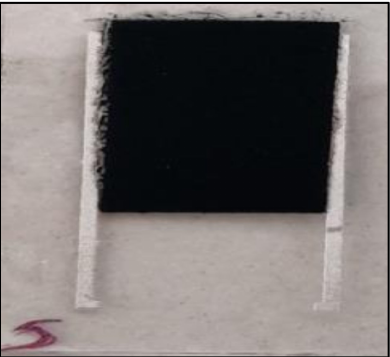
Figure 20. PANI/WO 3 /CuCl 2 screen-printed film with 5 prints.